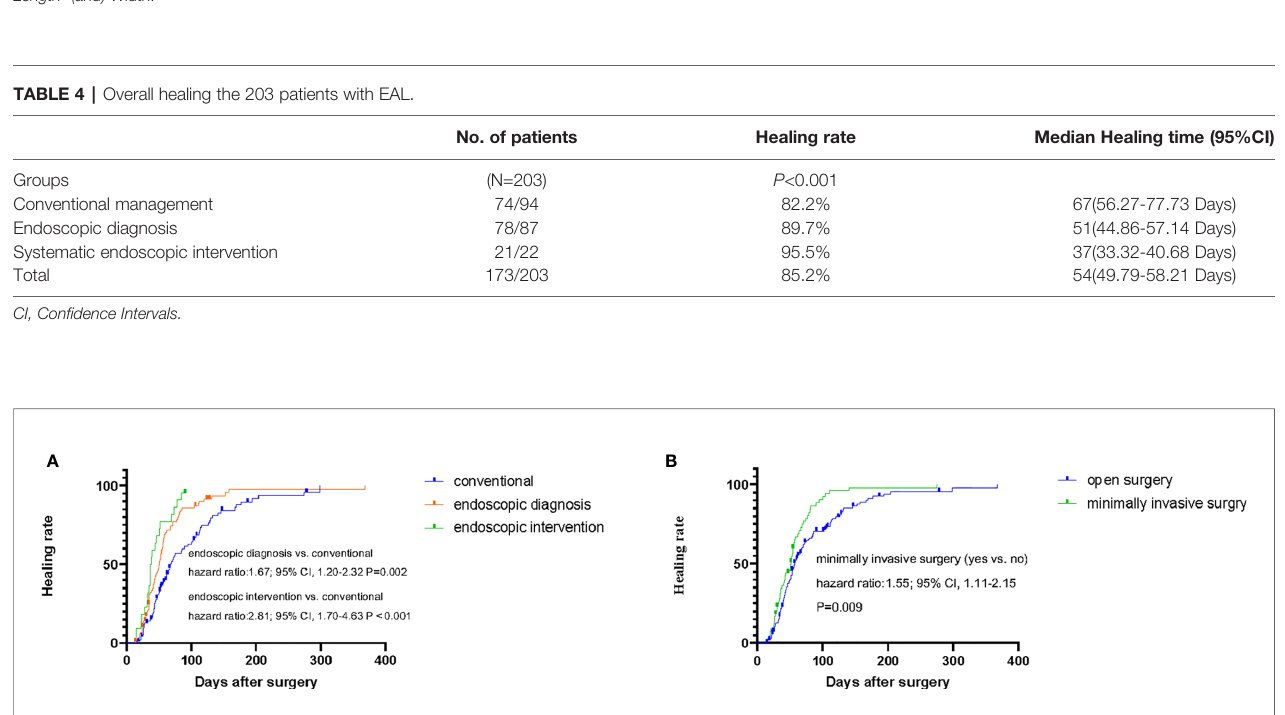
FIGURE 2 | (A, B) Kaplan – Meier curves for independent predictors of EAL healing.